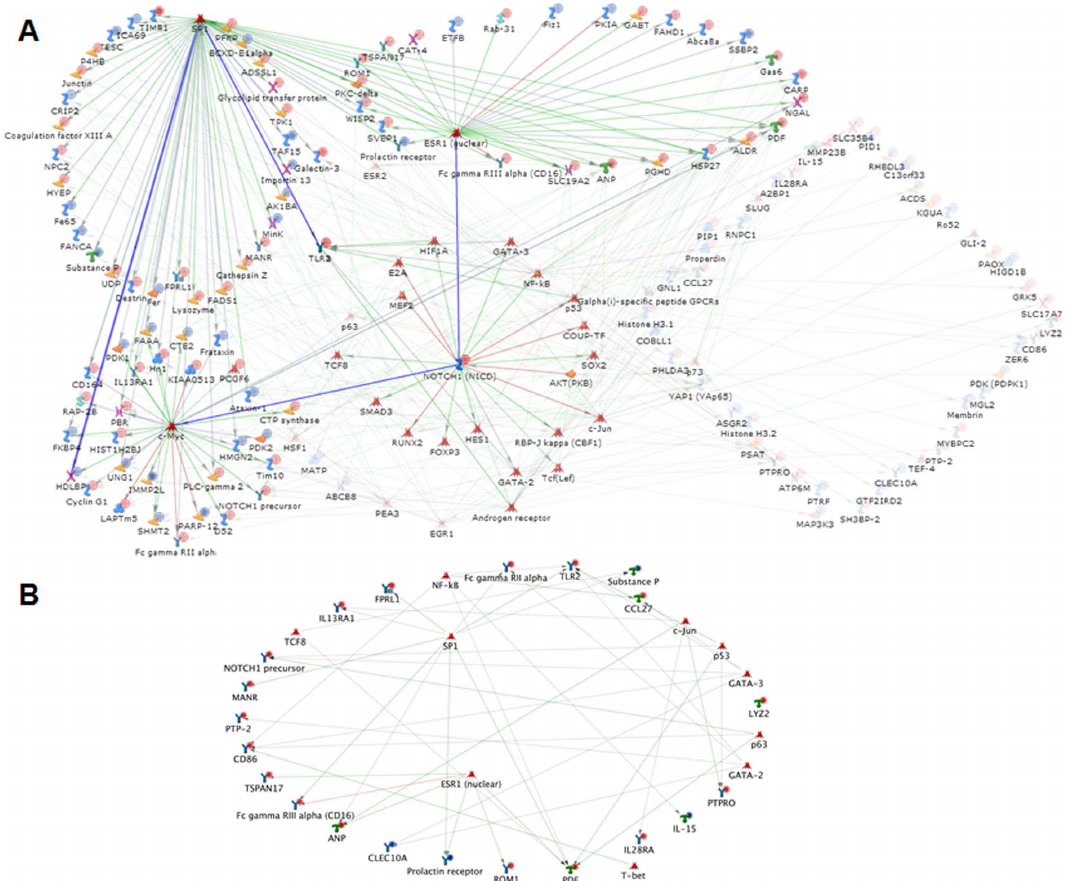
Figure 6. Network analysis of genes significant for genotype: List of significant genes (root list) varying by genotype was uploaded on to GeneGo portal and network built. Transcription factor network (A) was drawn using analyze network function for transcription factors. In this analysis for every transcription factor with direct ligand (s) in the root list, the algorithm generates a sub-network consisting of all shortest paths from that transcription factor to the closest receptor with direct target (s) in the root list. Receptor networks (B) was drawn using build network for your data option. Except receptors and receptor ligands, others were hidden from this network in order to visualize the alteration in receptor networks. The figure shows the differentially expressed genes in the network (Blue for down-regulated and Red for